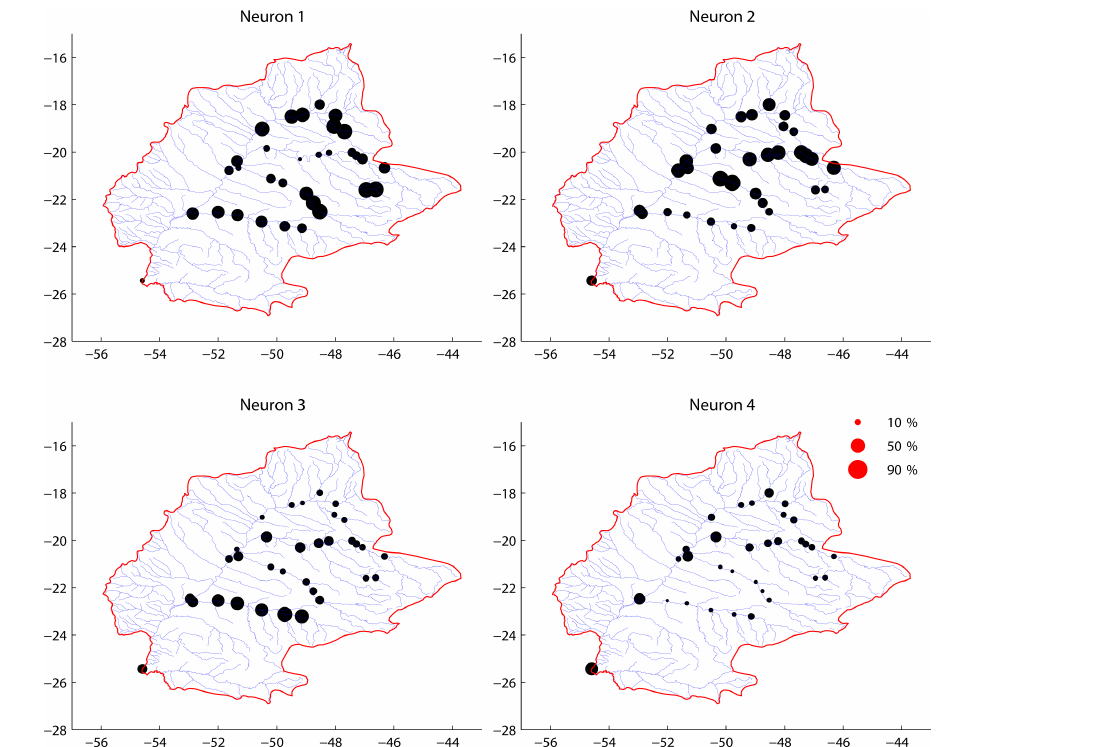
Figure 9. Frequency of flood events in each neuron class for each streamflow gauge. The red dots show the scale for frequencies of 10, 50, and 90%.